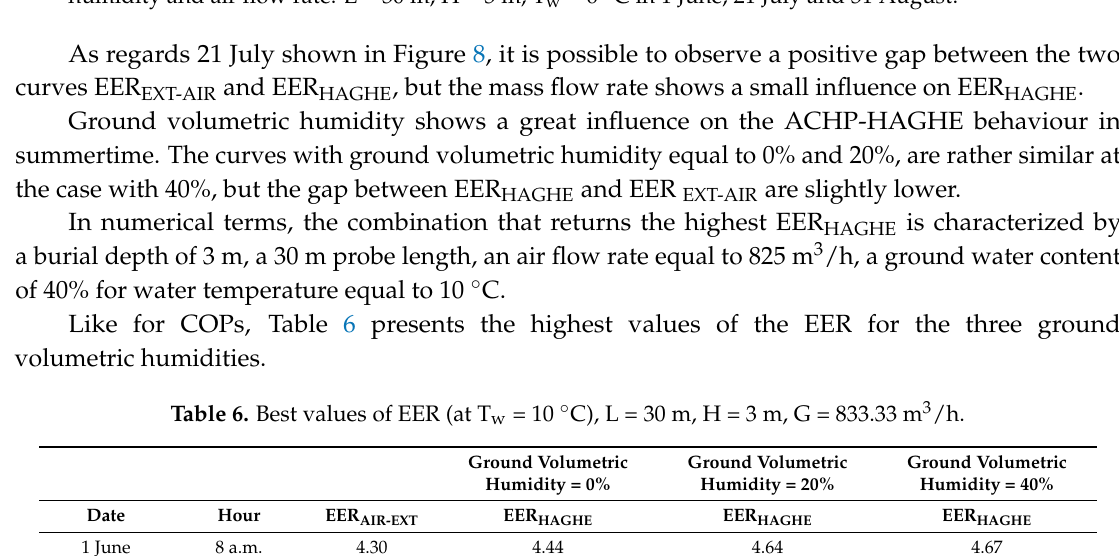
Figure 8. Hourly comparison between EER EXT ‐ AIR and EER HAGHE by varying ground volumetric humidity and air flow rate: L = 30 m, H = 3 m, T w = 6 °C in 1 June, 21 July and 31 August.